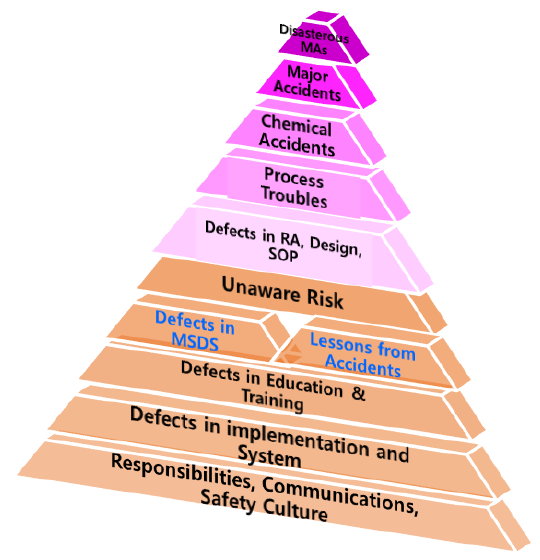
Figure 7. Root cause analysis (RCA) of chemical accidents.